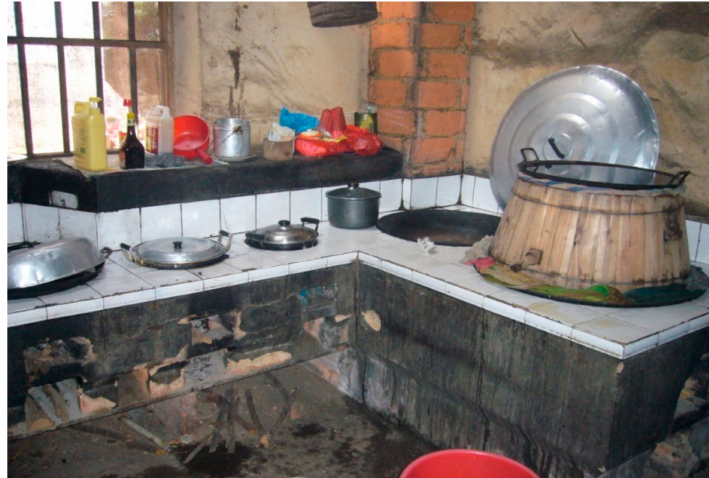
Figure 1. Household stove used in this